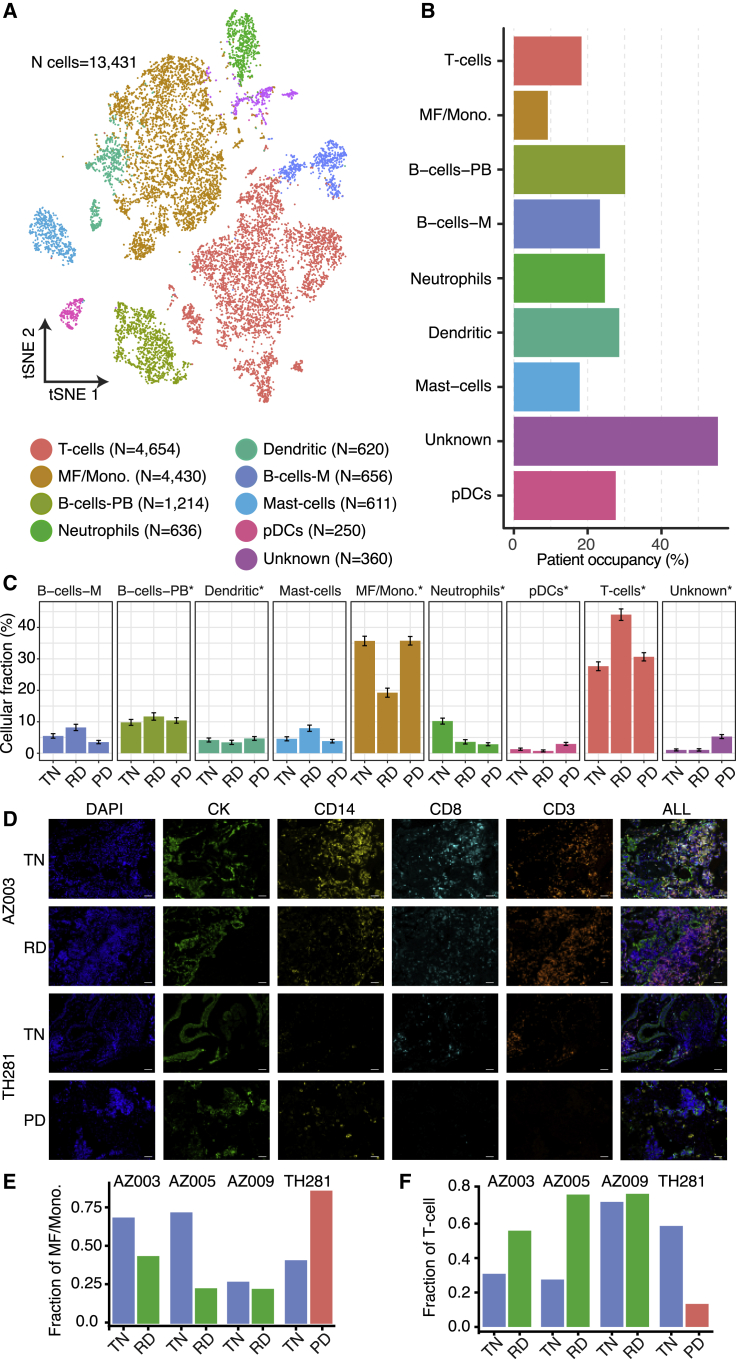
Changes in the Composition of the Tumor Microenvironment within Each Tumor(A) t-SNE plot of all immune cells colored by immune cell type.(B) Patient occupancy for each immune cell type.(C) Fractional changes for each immune cell type across the three treatment states. Error bars indicate the 95% confidence interval for the calculated relative frequencies. ∗p < 0.01 using a chi-square test of independence.(D) Representative in situ immunofluorescence images of changes from TN to RD and TN to PD in tumor tissue sections from two separate samples at two separate time points; AZ003 (TN and RD), TH281 (TN and PD). Scale bars correspond to 50 μm.(E) Quantification of fractional changes of macrophages across treatment time points from the images in (D) and Figure S5F.(F) Quantification of fractional changes of T-cells across treatment time points from the images in (D) and Figure S5F.See also Figure S6.